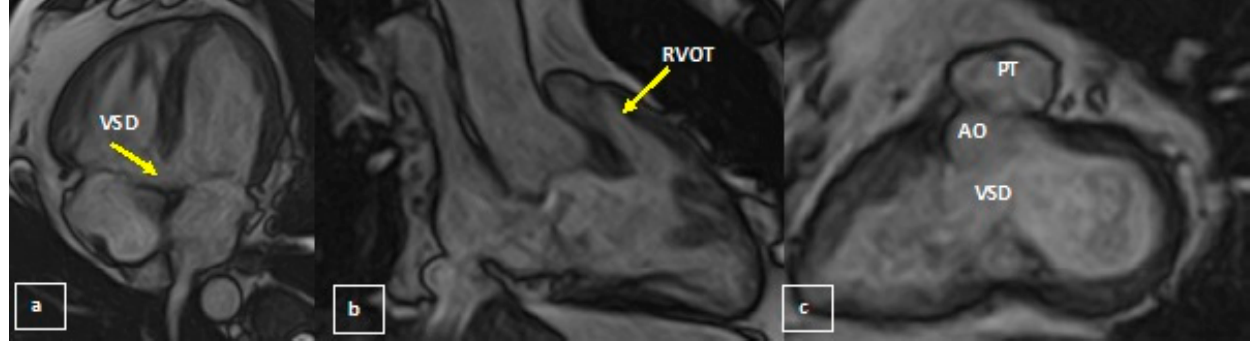
Figure 2. CMR: ( a ) horizontal long axis: subaortic ventricular septal defect; ( b ) RVOT: infundibular stenosis (with an RV outflow tract diameter of 13 mm); ( c ) short axis: subaortic ventricular septal defect and ascending aorta overriding the interventricular septum.